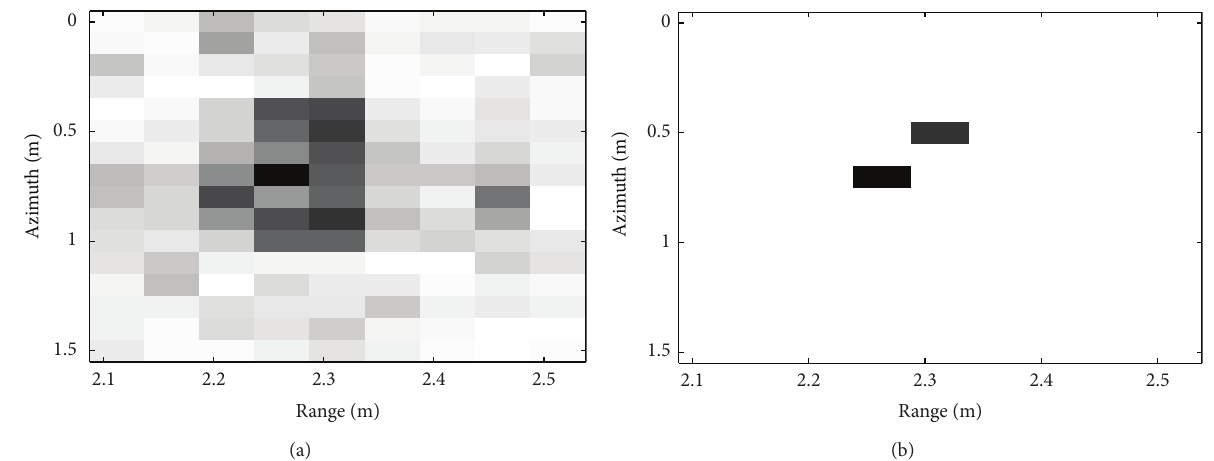
Figure 14: CS reconstructions of the behind-the-wall scene using a point-target dictionary. Downsampling factors were set to 60% for fast- time and 50% for azimuth. (a) 𝑙 1 -norm; (b) OMP.